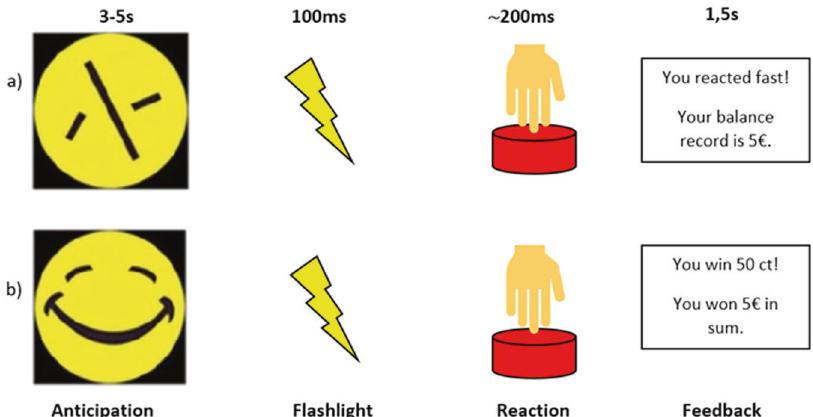
Fig. 1 Monetary incentive delay (MID) task. Event-related functional magnetic resonance imaging (MRI): 30 control conditions ( a ) and 30 winning conditions ( b ). In sum 60 trials. A circle ( a ) or a smiley ( b ) is displayed in the anticipation phase. Then a fl ashlight appears and the participant has to react as fast as possible by pressing a button. After the reaction, a feedback is shown: control condition ( a ): feedback about the success of the reaction and winning condition ( b ): feedback about winning money — 50 cents or a booster of 2 € .